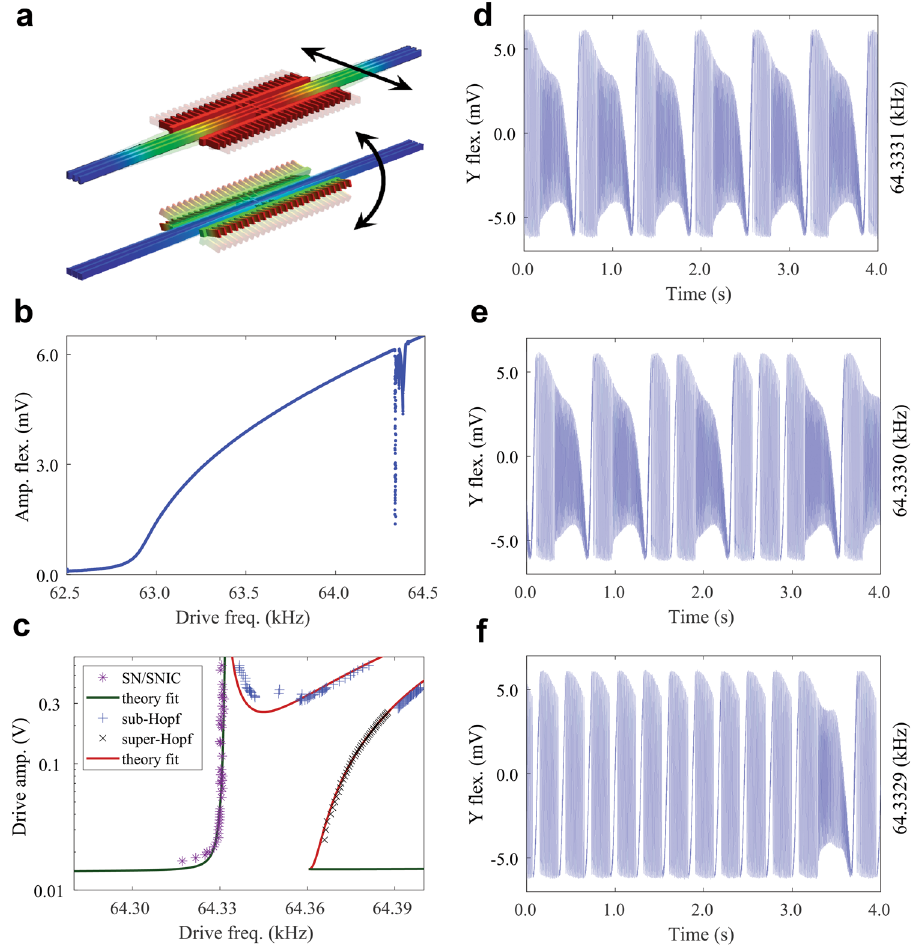
Fig. 1 | Operating principles and resulting dynamics of the mechanical reso- nator. a Simulated in-plane fl exural (top) and torsional (bottom) modes of the resonator. Arrows indicate the direction of motion. b Resonator ( fl exural motion) response when driven into the nonlinear regime. Reductions in the average amplitudeoftheresonatorresponsecorrespondtoaregionofinternalresonance. c The bifurcation diagram predicted by the fi tted model, displaying dynamically differentregionsclosetotheIR;seeSIandref. 17 fordetails.Themodelwas fi ttedto the measured saddle-node(SN),saddle-node on invariant circle (SNIC),subcritical andsupercriticalHopfbifurcationpoints.AsthedrivefrequencyapproachestheIR